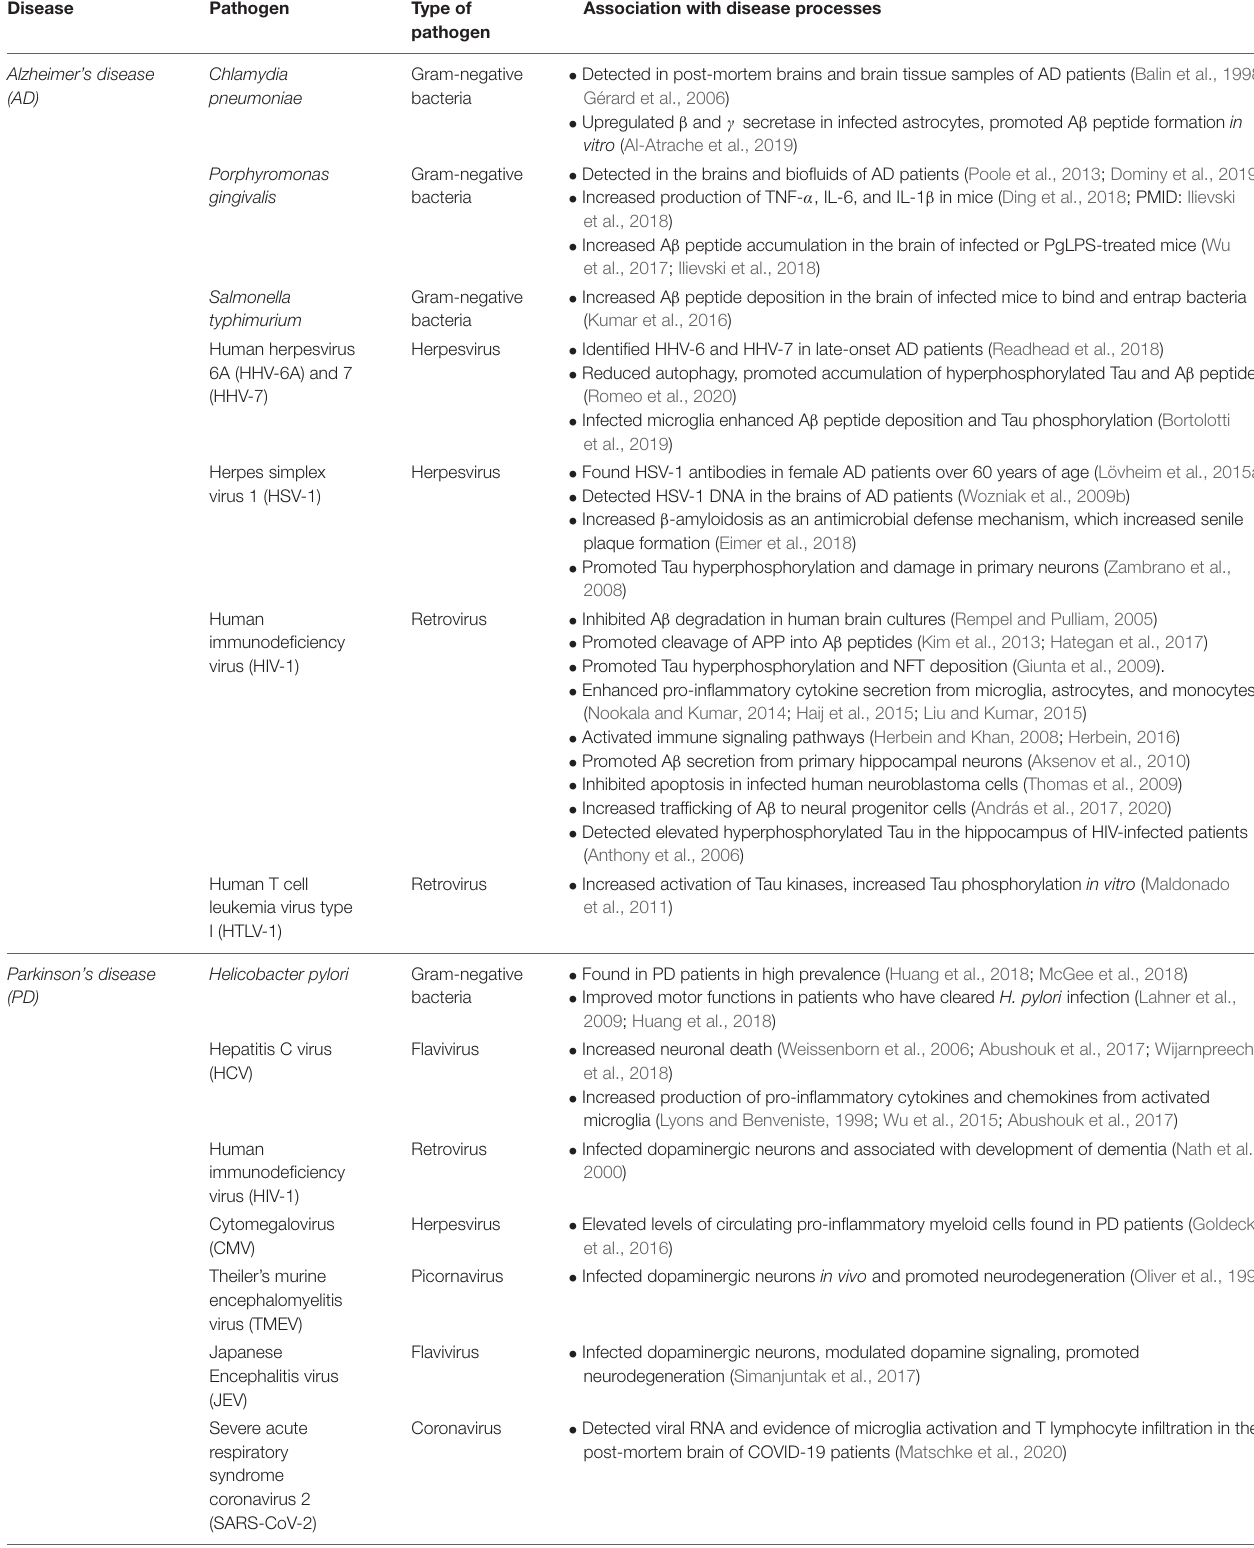
TABLE 1 | Overview of infections associated with neurodegenerative diseases.